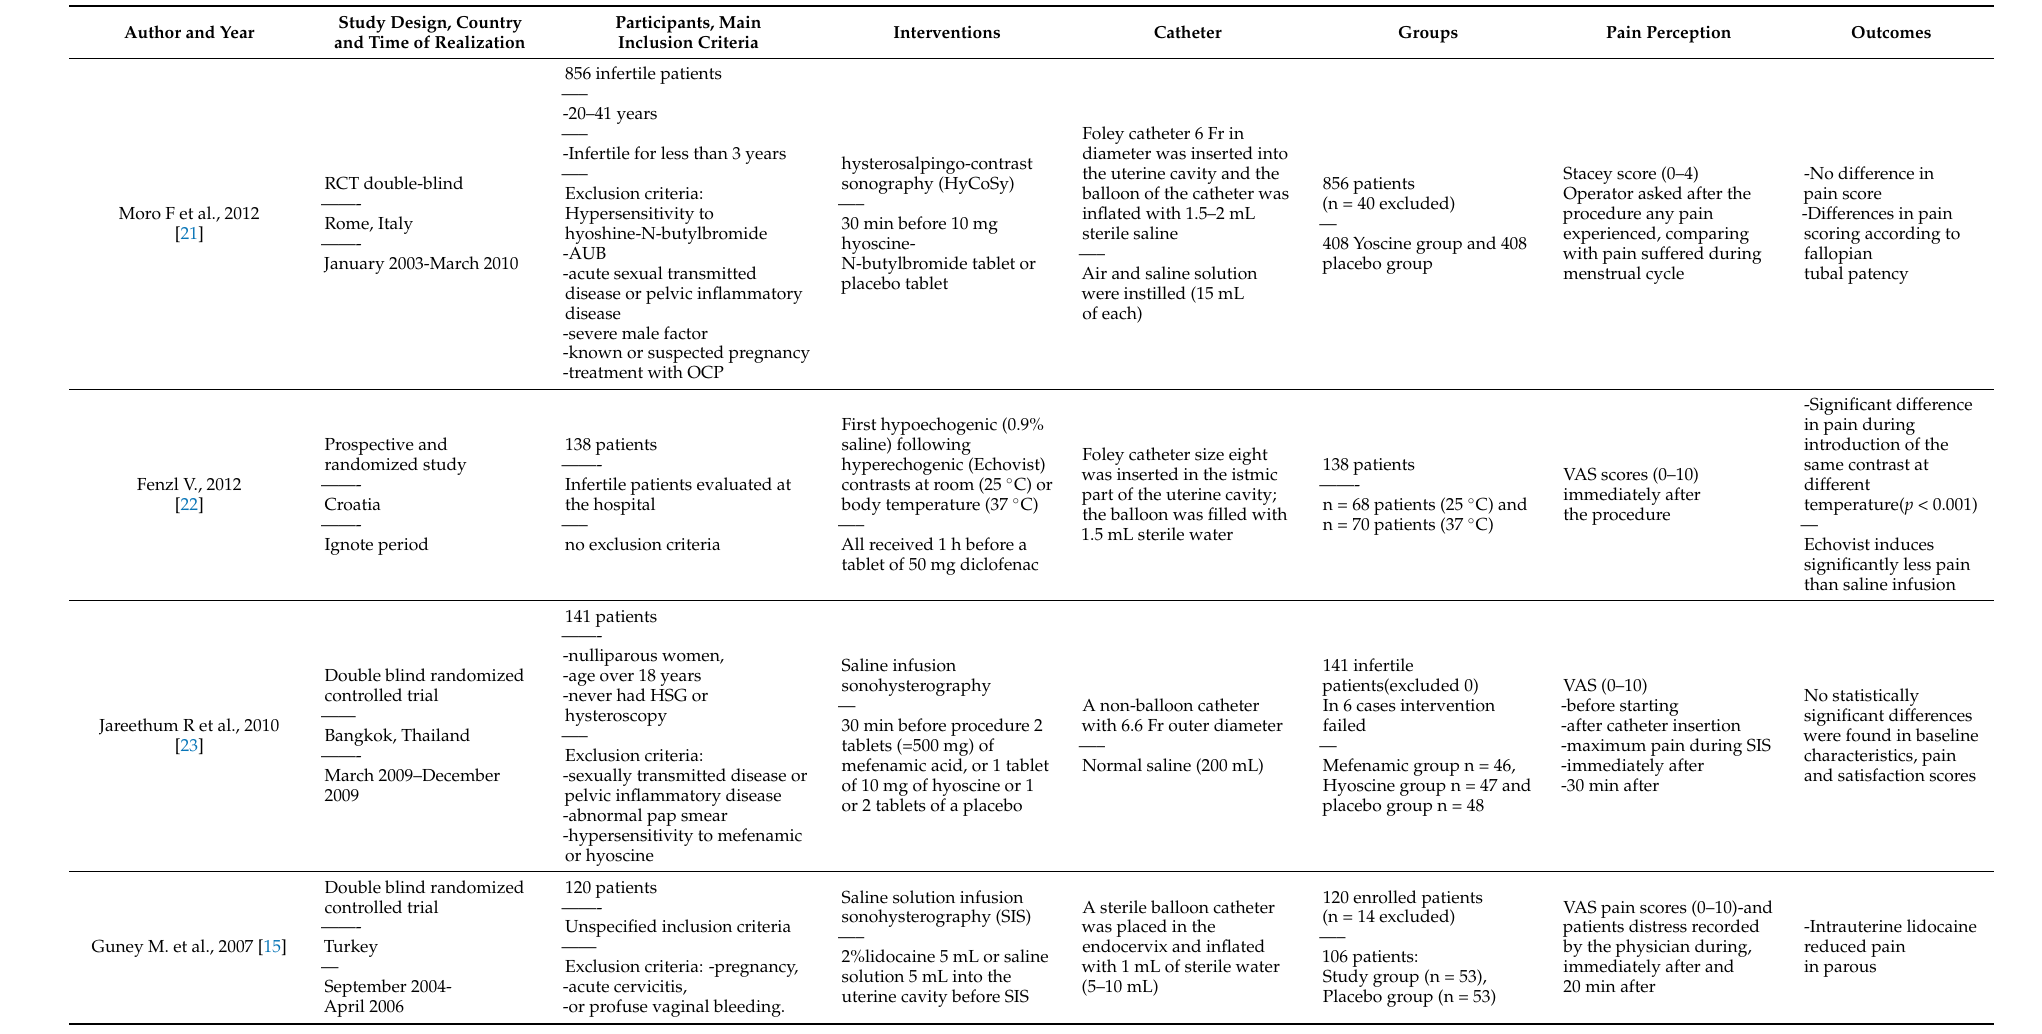
Table 1. General Features of the